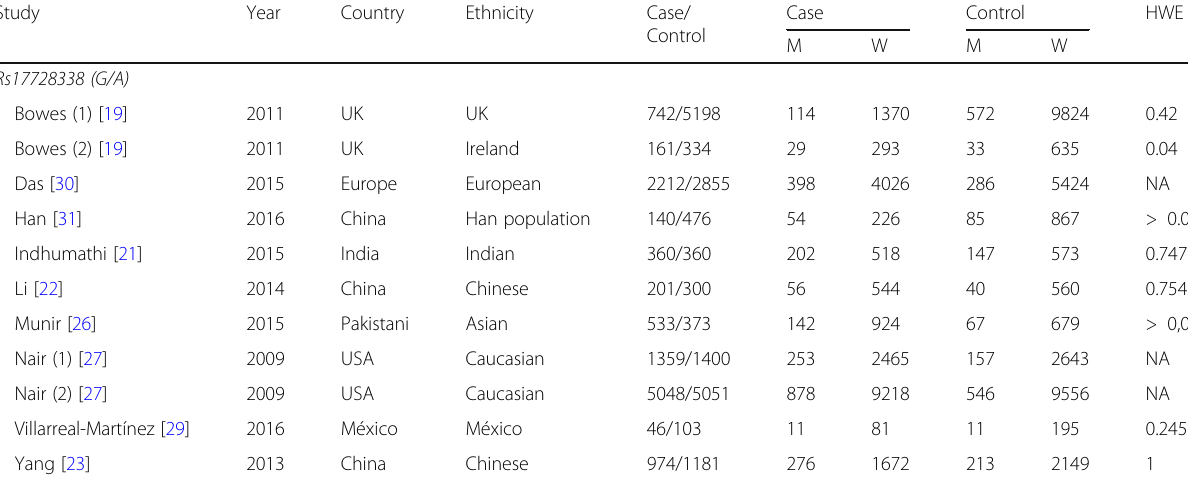
Table 2 Main characteristics of included studies